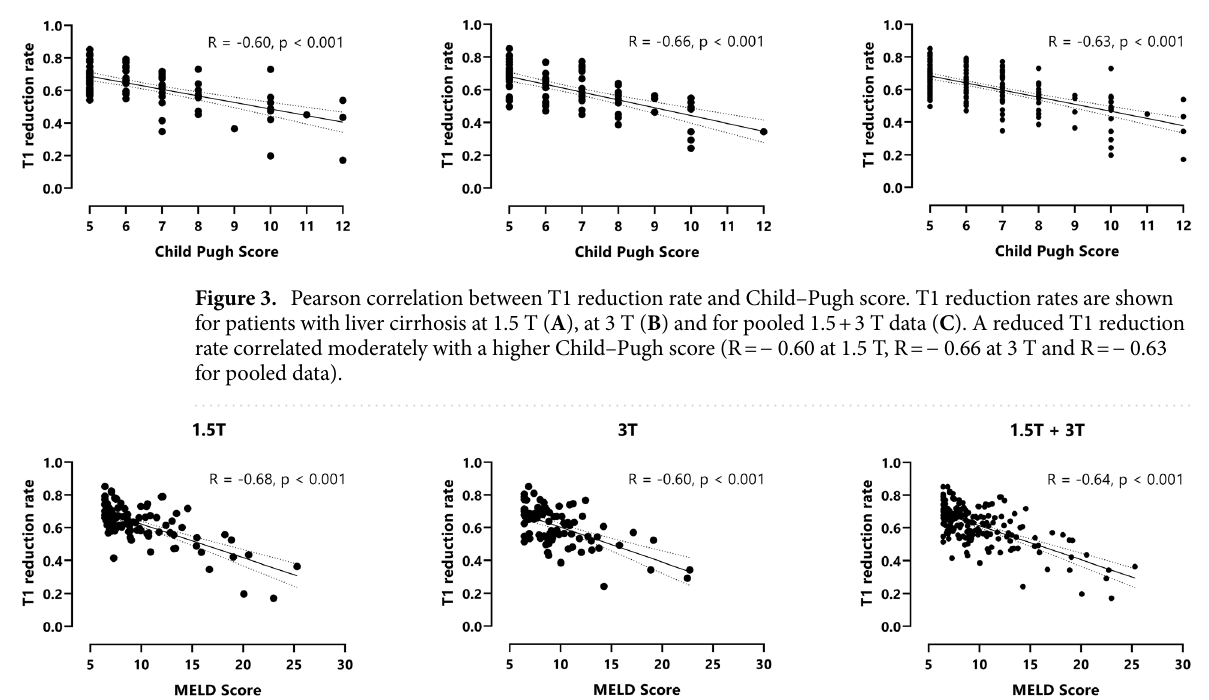
Figure 4. Pearson correlation between T1 reduction rate and MELD-Score. T1 reduction rates are shown for patients with liver cirrhosis at 1.5 T ( A ), at 3 T ( B ) and for pooled 1.5 + 3 T data ( C ). A reduced T1 reduction rate correlated moderately with a higher Child–Pugh score (R = − 0.68 at 1.5 T, R = − 0.60 at 3 T and R = − 0.64 for pooled